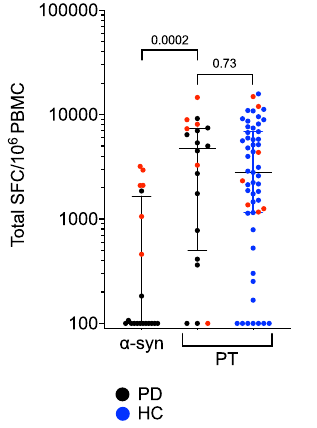
Figure 1. Magnitude of responses against α-syn and PT peptides. Magnitude of responses (sum of IFNγ, IL-5, and IL-10) against α-syn and PT peptides as SFC per 10 6 cultured PBMC (14-day in vitro expansion). Each point and symbol represents one participant. Red symbols indicate participants that were selected for TCR sequencing. Median ± interquartile range is